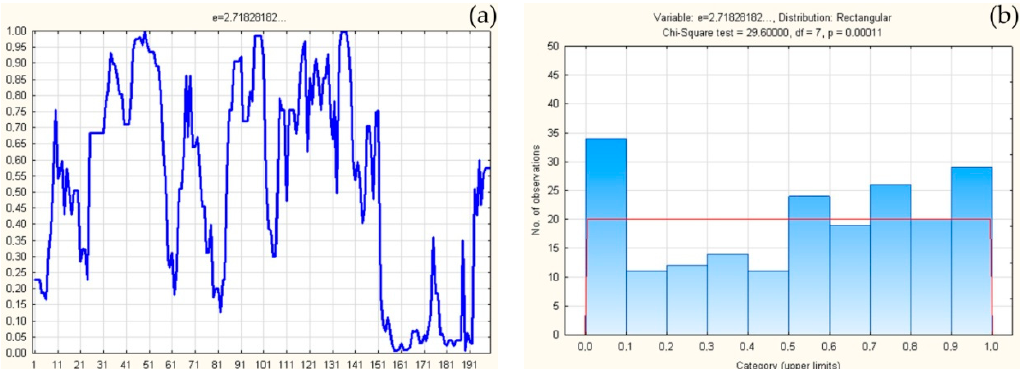
Figure 4. Exponential distributions of all 200 sets ∆ ↓ [e(i)] ( a ), verifications, and distribution of verifications ( b